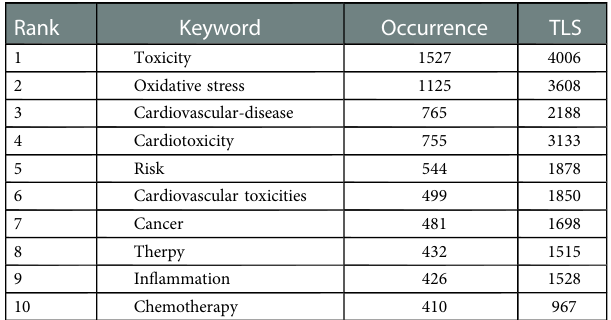
TABLE 6 The top 10 keywords in co-occurrence frequency of